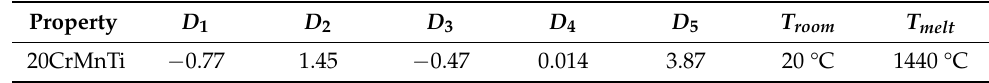
Table 3. Johnson-Cook damage constants for 20CrMnTi.